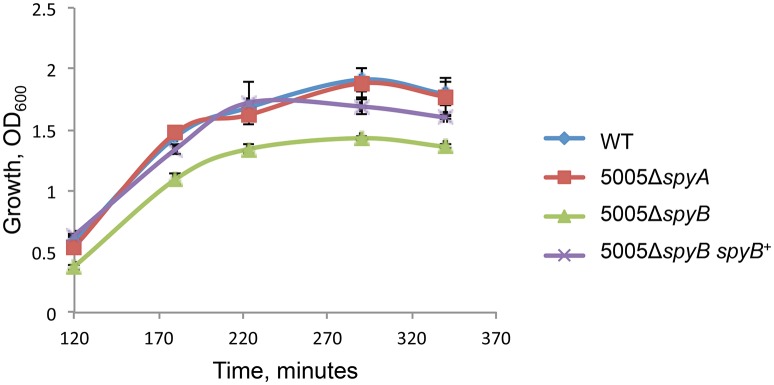
Growth of the MGAS5005 (WT), 5005ΔspyB, 5005ΔspyB spyB+, and 5005ΔspyA in THY medium. The data are the mean of three independent experiments ± standard deviation.